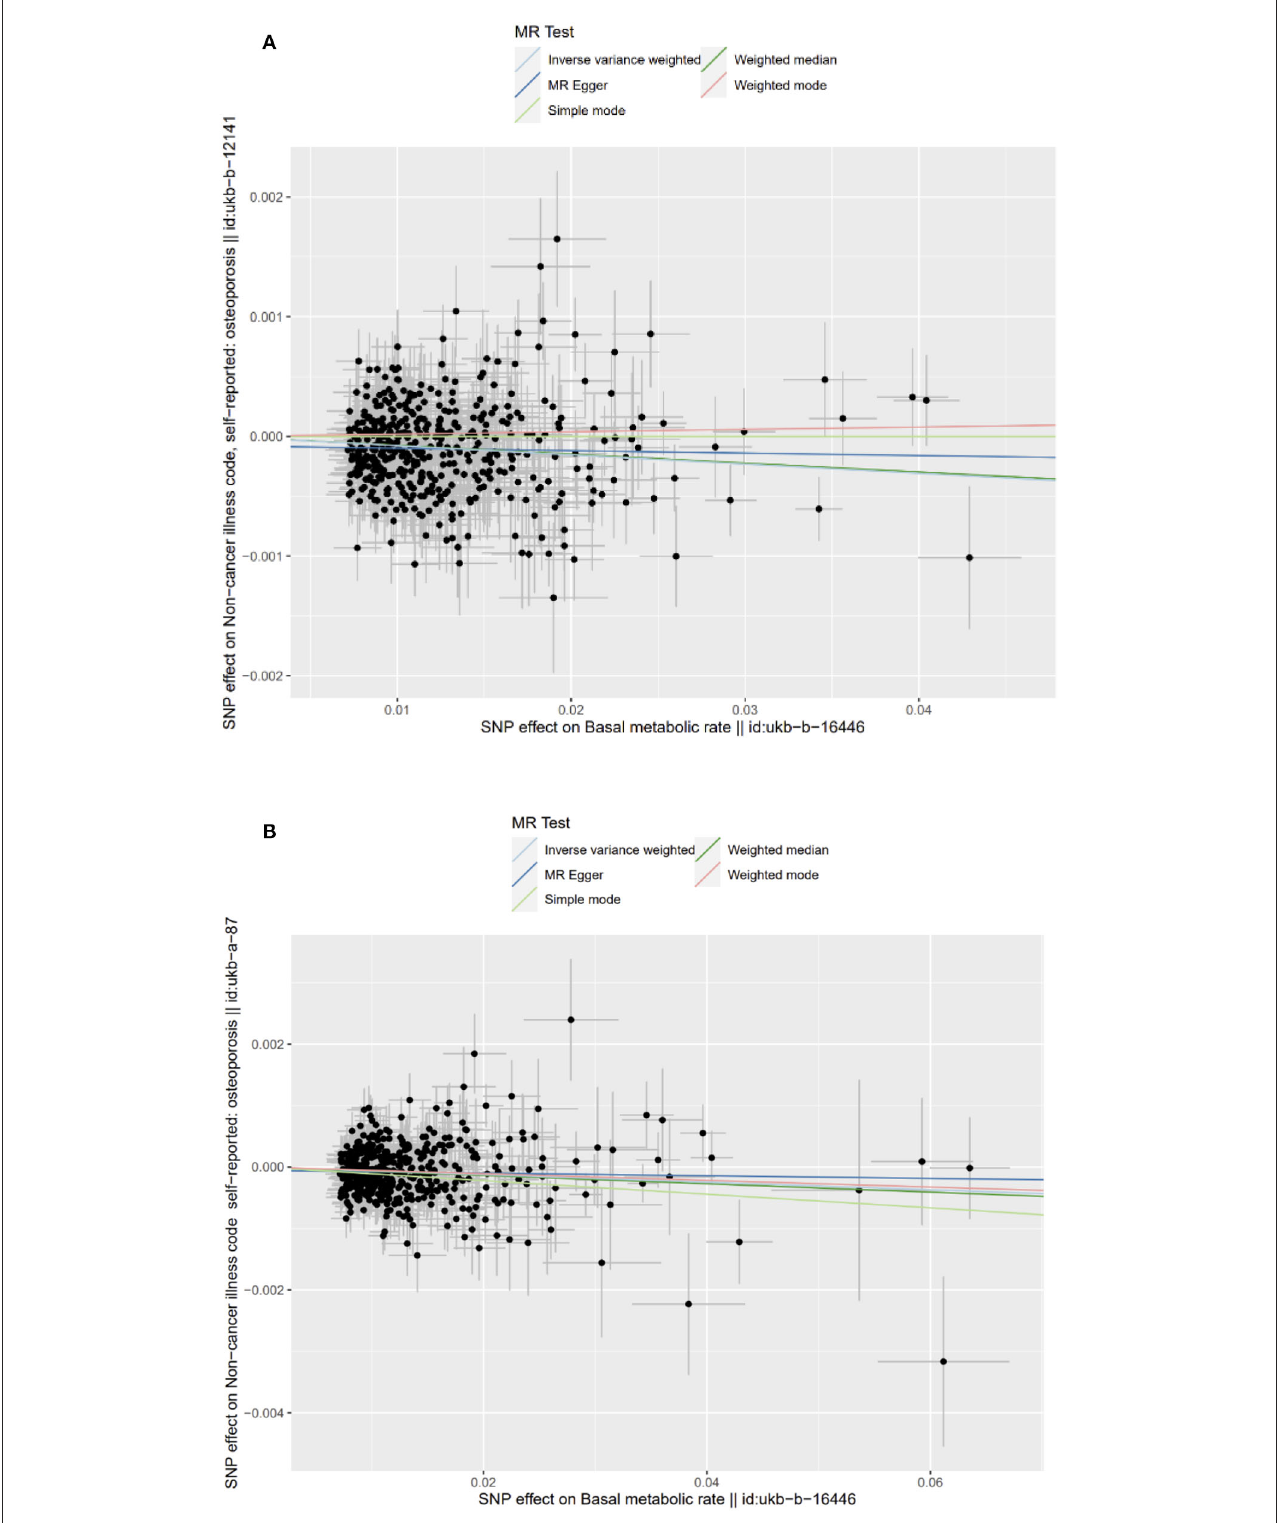
FIGURE2 Scatter plots of causality. The slope of each line corresponding to the estimated MR effect in different models. (A) Primary outcome (ukb-b-12141); (B) Secondary outcome (ukb-a-87).